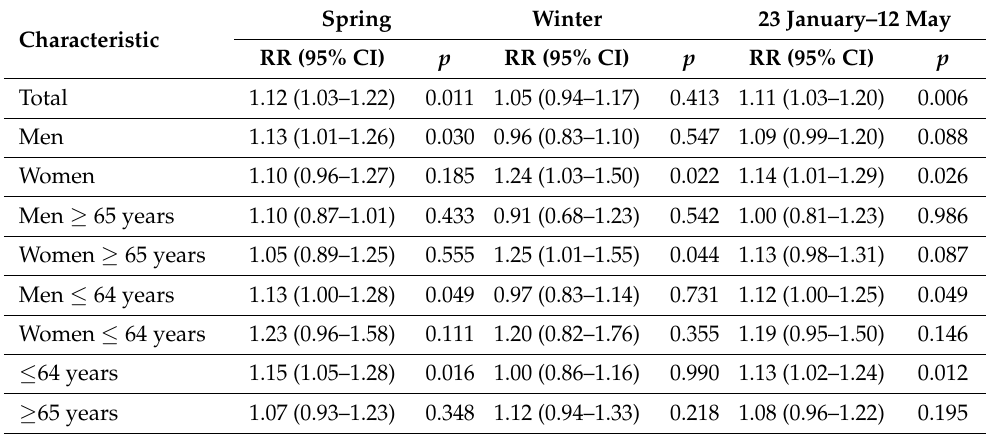
Table 5. The effect of mean values of PM 10 during 5–11 days before on the risk of fatal AMI during spring, winter, and the period of the highest level of exposure (23 January–12 May).